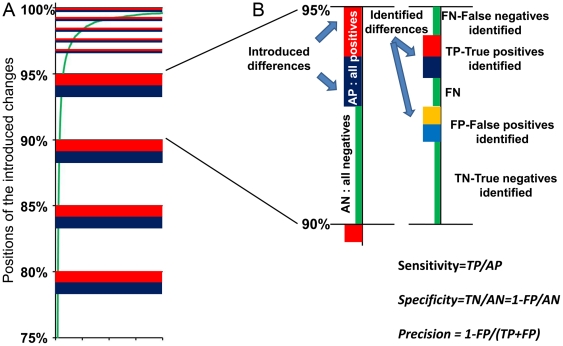
Test system for determination of the Sensitivity and specificity of the differential gene expression analyses.A supposedly homogeneous group of samples was divided into two equal subgroups, one of which was not changed and used as a control and the other used as an experimental group with introduced changes (Supplemental Tables S2, S3, S4 and S5). All data (∼20,000 genes) were divided into 20 equal blocks. A) A fragment of experimental data set. The data are sorted according the averaged level of expression (green line, shown relative to the maximum expression level units). The figures on the left side of vertical axis show the positions of each block (in percents of the total data). Positive (red) and negative (blue) changes were introduced in the 20% portion of genes in the block (usually changes applied to the genes with highest expression in each block, excluding the first one containing the very first 100 genes with highest expression levels. Here 40 differentially expressed genes created within each of five 200 gene segments). B) Structure of one of the blocks (90–95% of data). Left vertical axis presents positions of positive (red) and negative (blue) introduced changes with the rest (green) positions of unchanged gene expressions. Right vertical axis shows selections made by an analysis: red/blue – correct selection of +/− changes, yellow/light blue – false selection of +/− changes among not changed genes, green marked FN – false negative selections (not identified + or − changes), green marked TN – true negative selections. Sensitivity of selections is determined here as a proportion of true positive selections within all produced changes, Specificity determined as a a proportion of true negative selections among all unchanged genes, and Precision is determined as a proportion of true positive selections among all selections made by an analysis, or as a value whose deviation from 1 is associated with the presence of false positive selections.